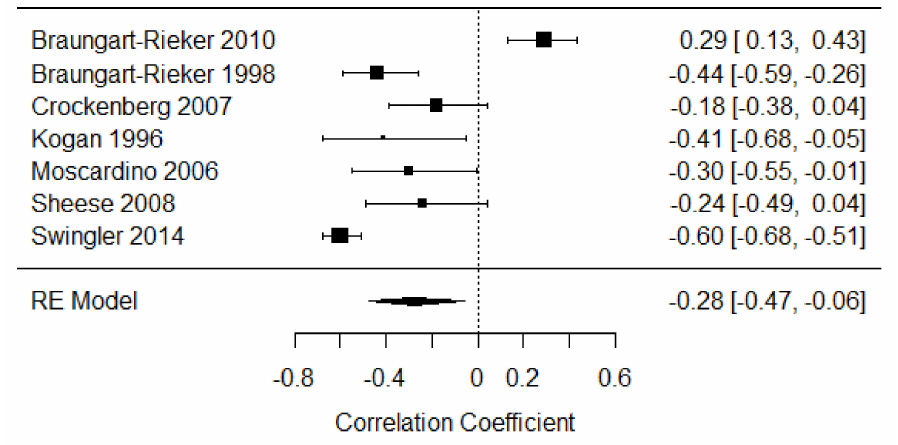
Figure 3. Forest plot of year 1 disengagement of attention. Note: RE = Random-Effects Model. Second Year of Life